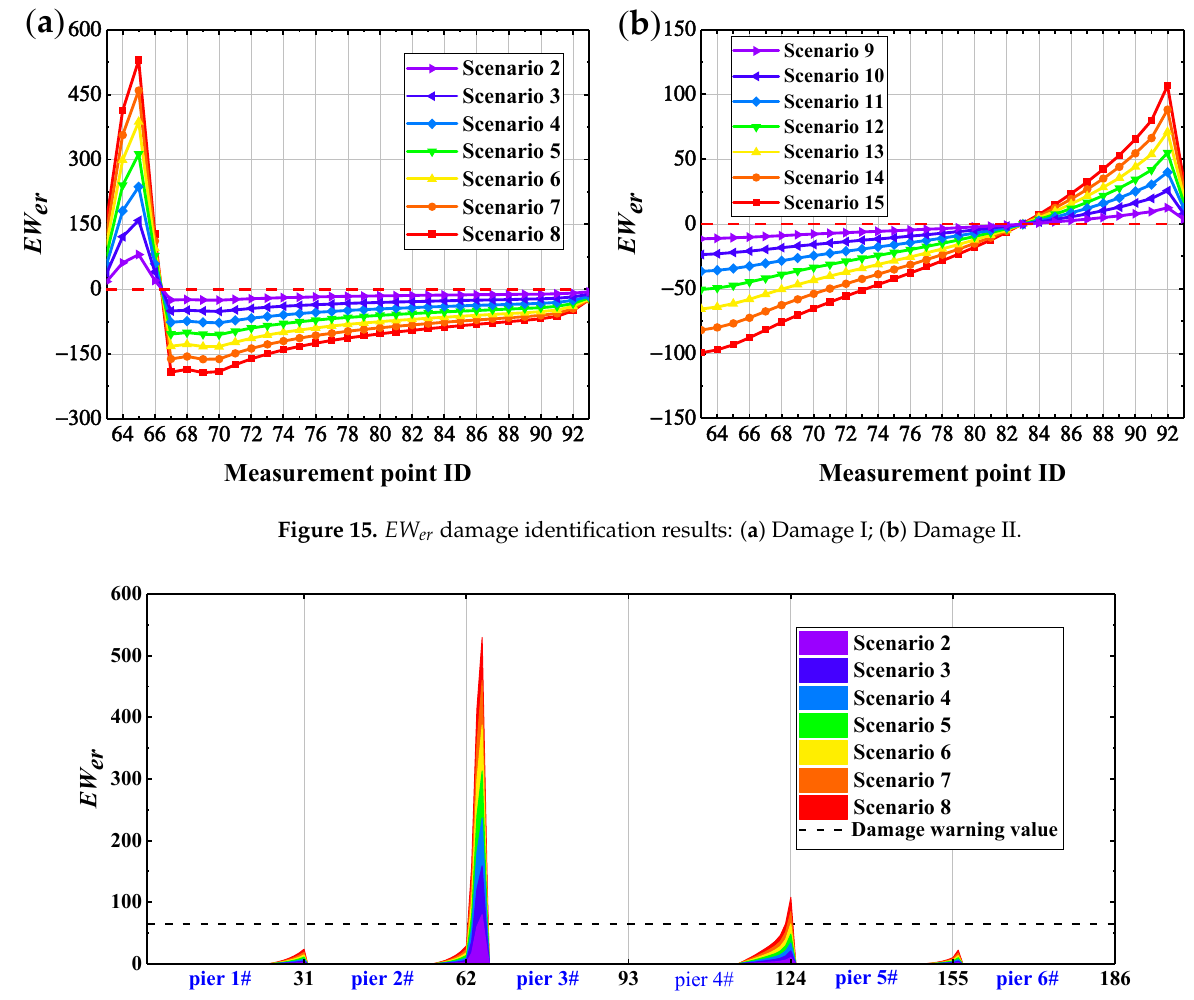
Figure 17. SEW er identification results of damage of 6 bridge II piers.